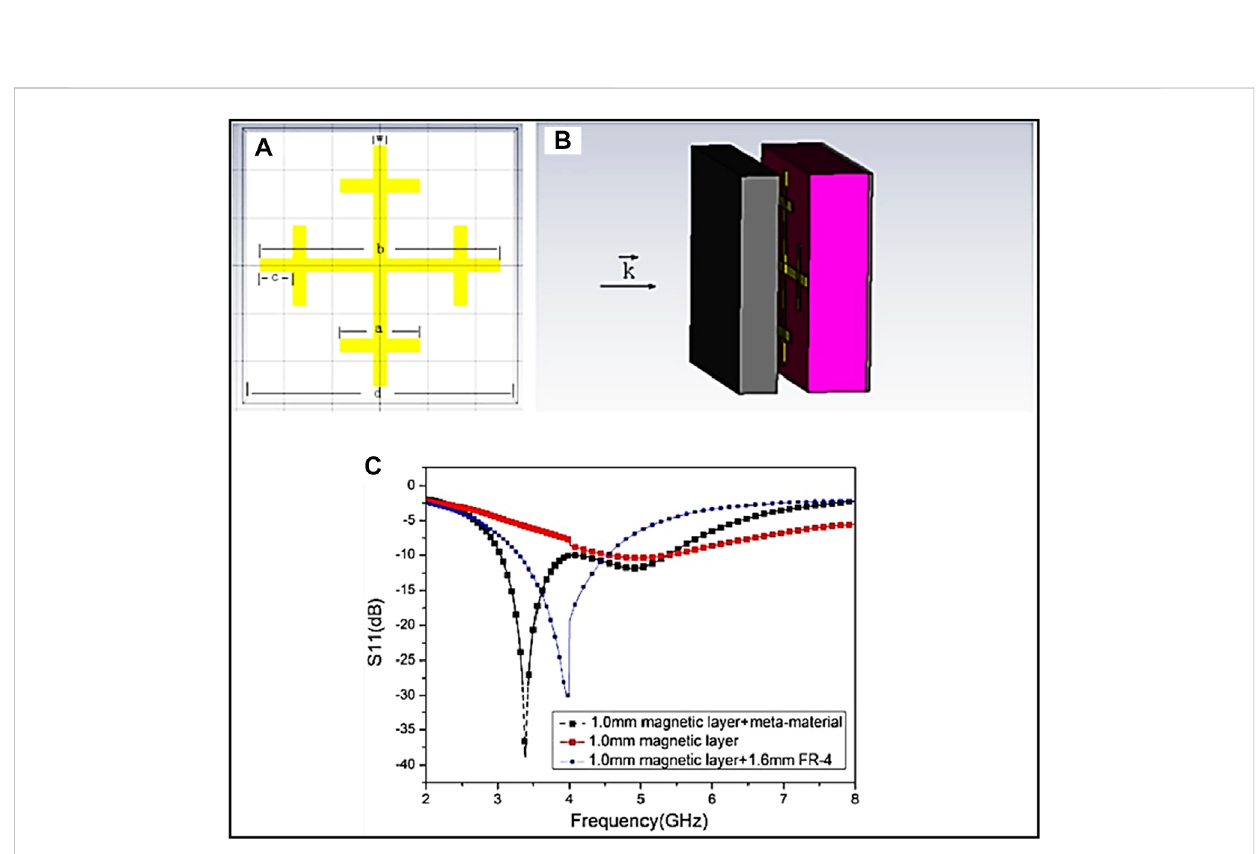
FIGURE 18 (A) Schematic of a metamaterial structure. (B) General con fi guration. (C) S11 curves of various structures (Huang et al., 2014).